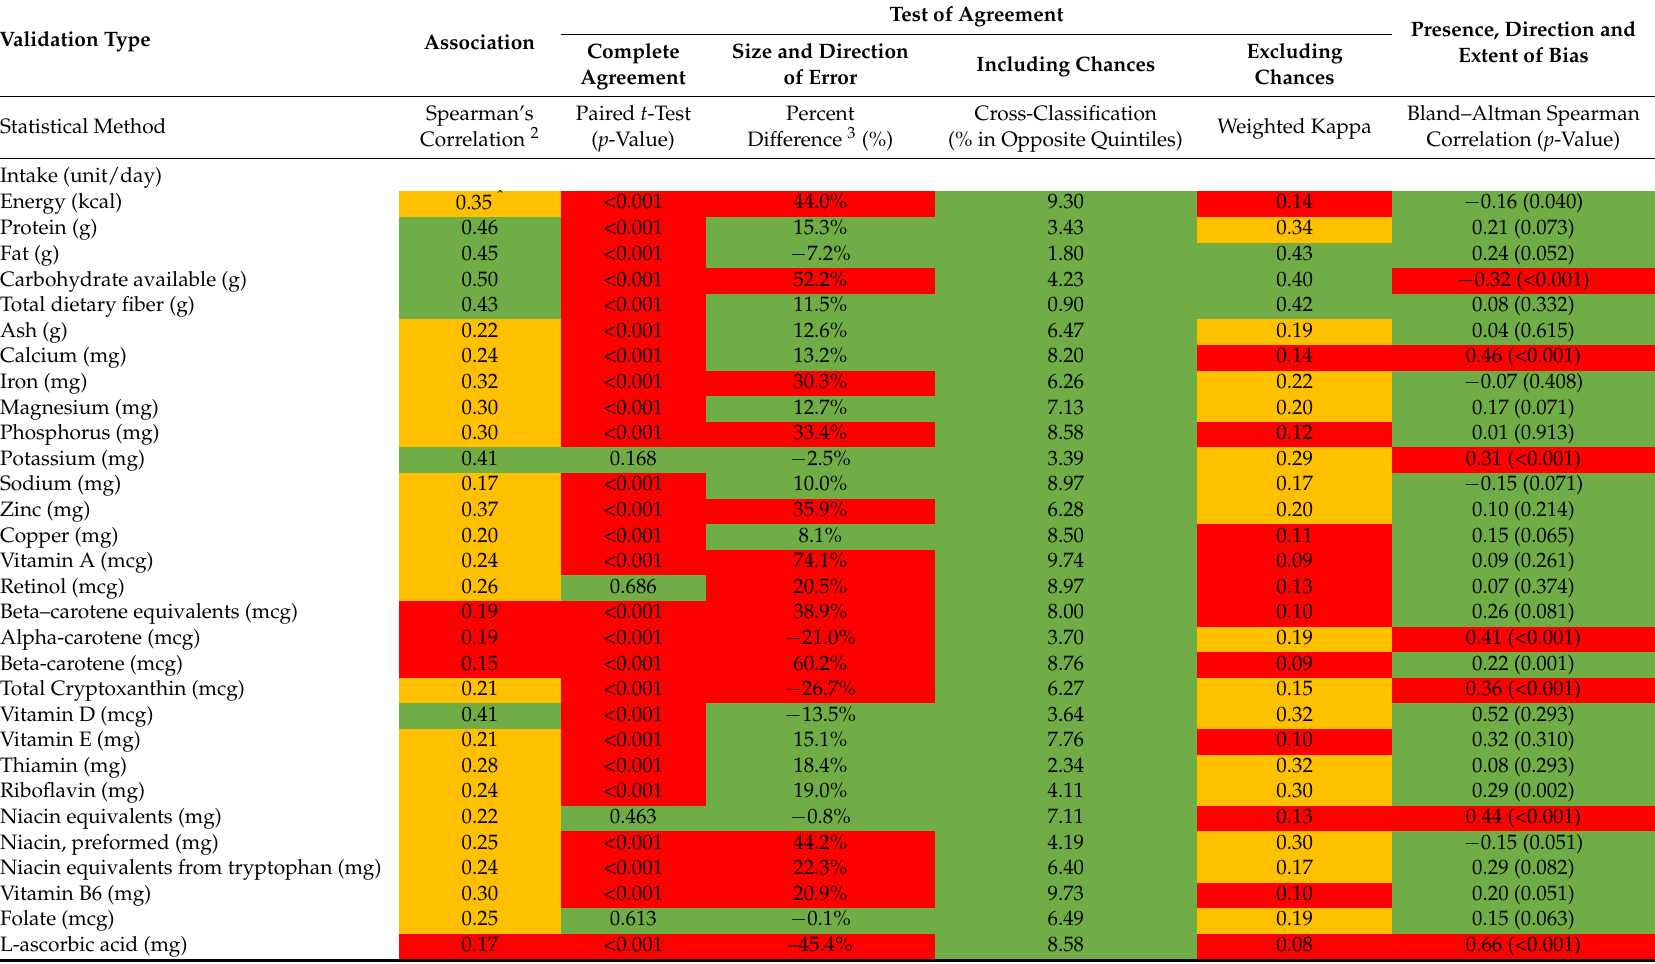
Table 6. Statistical test outcomes and interpretations 1 for nutrient